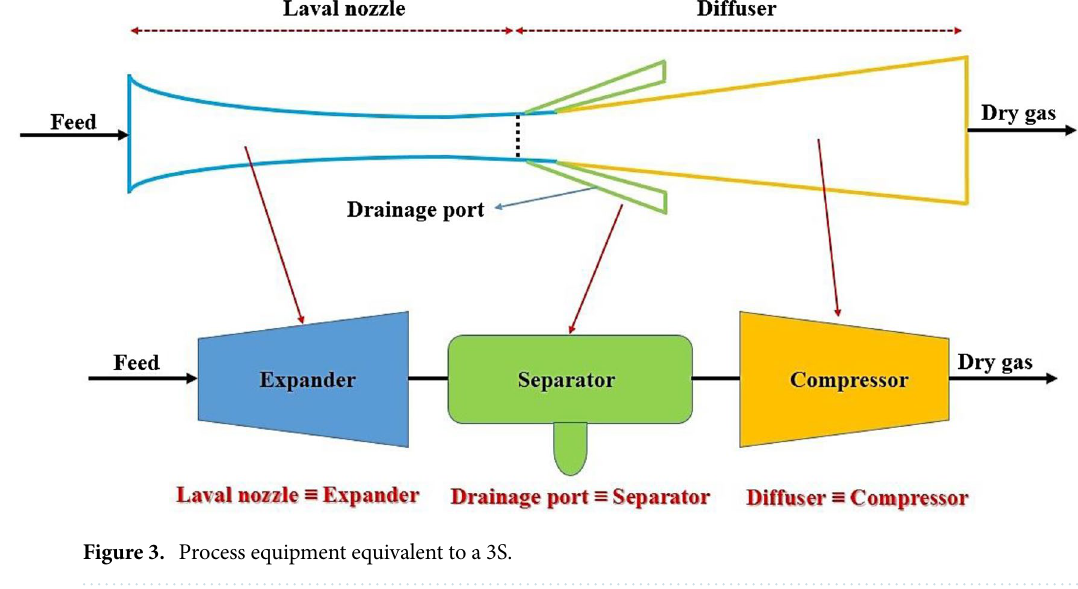
Figure 3. Process equipment equivalent to a 3S.